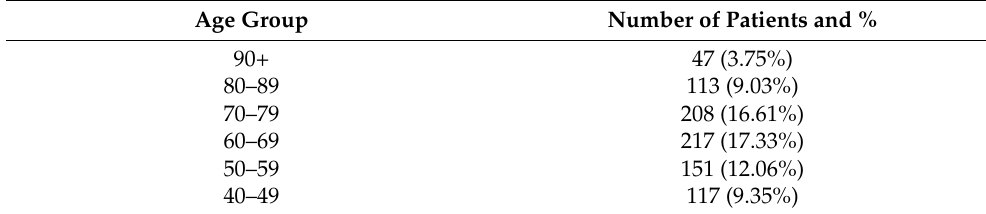
Table 1. Characteristics of the analyzed